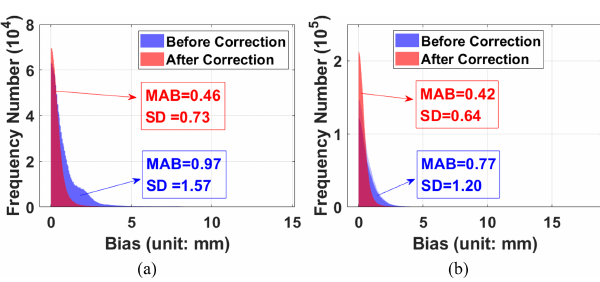
Figure 9. Frequency distribution of MABs over July (a) and the whole year (b) of 2020 before and after